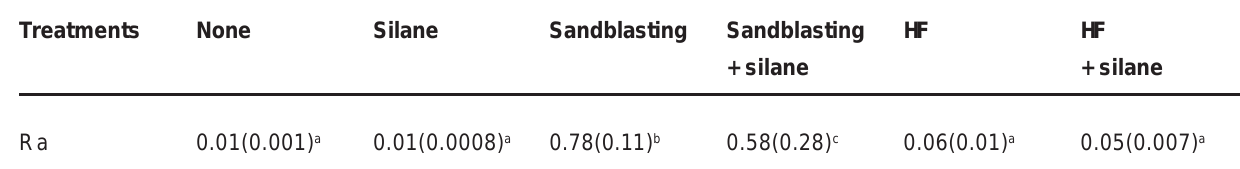
TABLE 3- Mean roughness values (Ra) before and after surface treatments, expressed in µm(sd) (n = 5) Mean values with the same letters are not statistically significantly different (p >